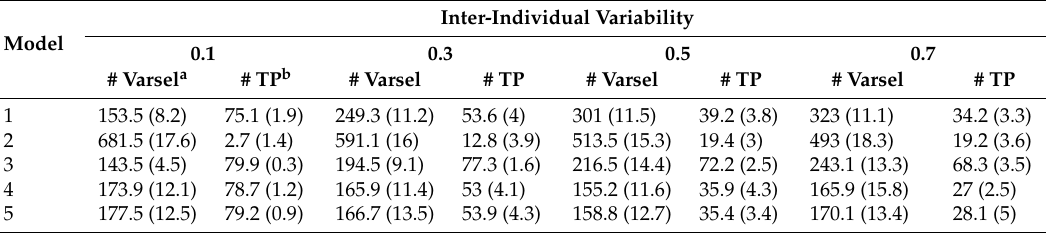
Table 4. Influence of inter-individual variability on variable selection performance of five models on simulated data.